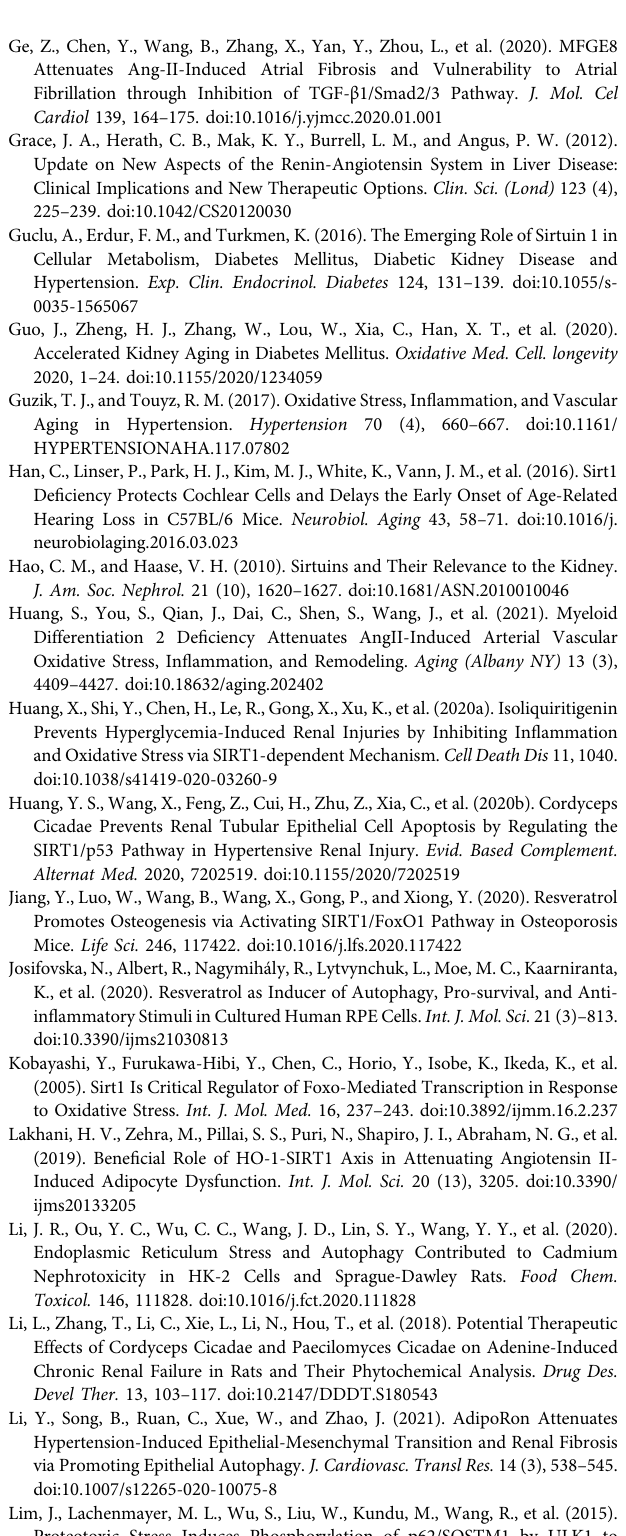
Supplementary Figure 3 | LC-MS/MS identi fi cation of no chemical substances added into C. cicadae